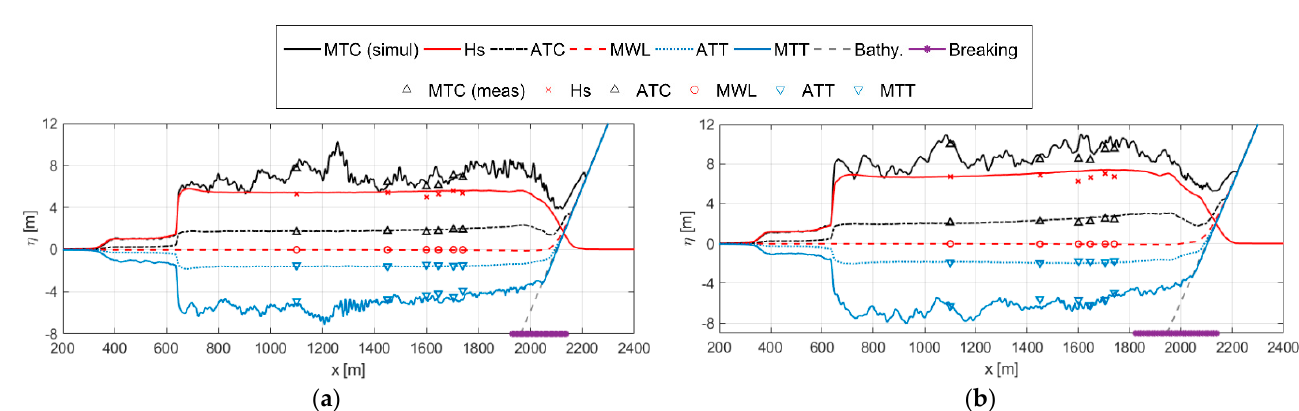
Figure 1. The wave-print for the two cases for which experimental data are available: in ( a ) for case H6T12, and in ( b ) for case H7.5T16, with bottom friction. At the left of the influx point, before the damping zone, the difference in the value of MTC and that of MTT show quite substantial reflected